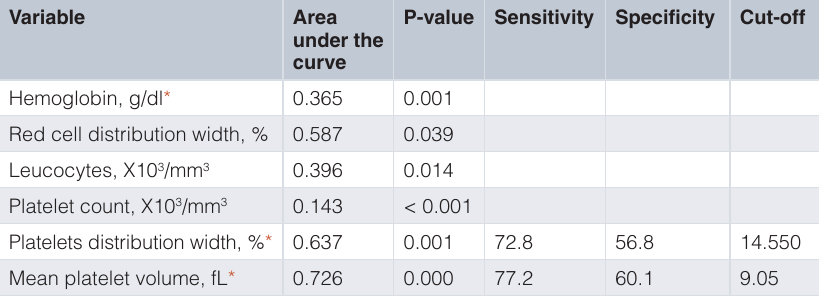
Table 3. The reliability of haematological indices in predicting